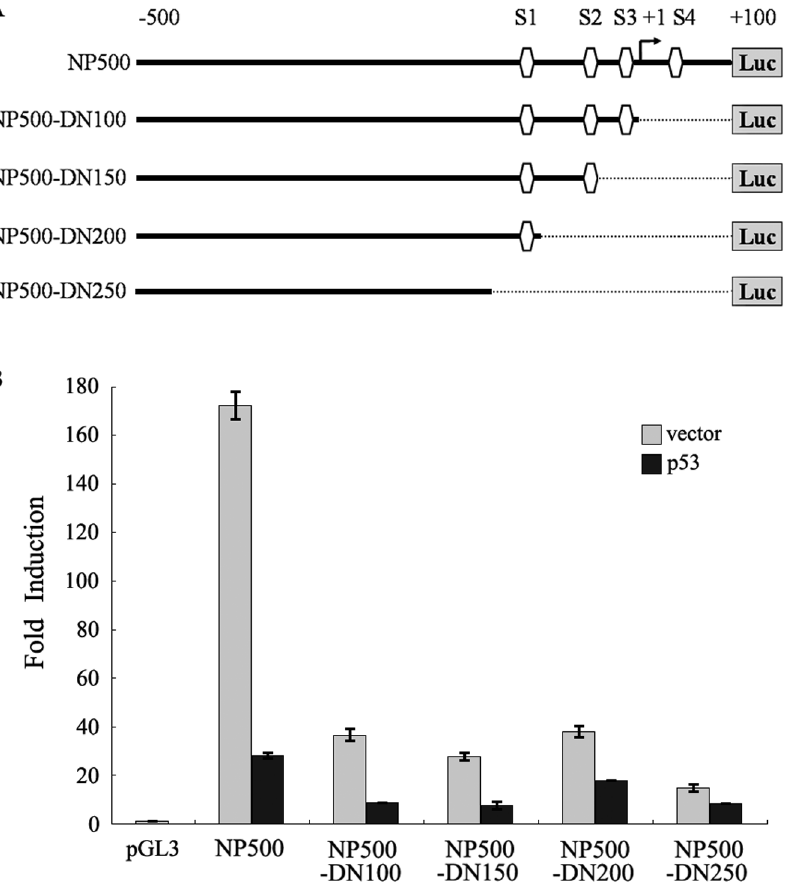
Figure 5. Identification of the essential RLIM promoter regions required for p53 mediated transrepression. ( A ) Schematic representation of the RLIM promoter luciferase reporter NP500-Luc ( 2 500/ + 100) and various 3 9 serial deletions luciferase reporter constructs of the RLIM promoter (NP500-DN 100 to NP500-DN250). The four putative Sp1 binding sites S1 to S4 are highlighted (denoted as the ). The broken line ( … ) indicates the deleted region of individual construct. The arrow indicates the transcription start site. ( B ) Various RLIM promoter luciferase constructs described in Figure. 5A or control pGL3 vector were transfected into cells for luciferase reporter assays. For p53, 10 ng of pCMV-HA-p53 plasmid was used. For vector, 10 ng of pCMV-vector plasmid was used. Aliquots of cell extracts were assayed for luciferase activity as described